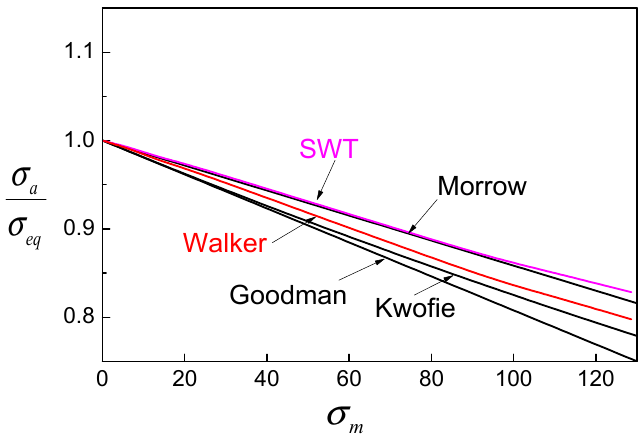
Figure 3. Comparison of different modifications of fatigue models.